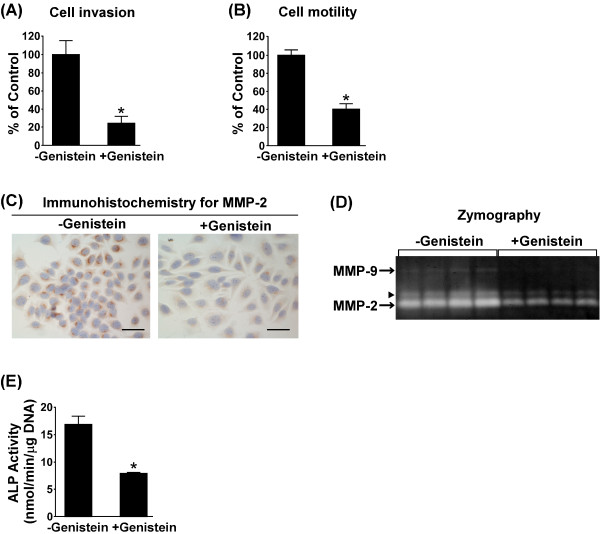
Effect of genistein on invasion, motility, MMP-2, andALP. (A and B) LM8 cells were treated for 3 days without or with 50 μM genistein and harvested by trypsinization. Cell invasion and motility assays were performed using either matrigel-coated membranes (A) or uncoated membranes (B). *p < 0.01 (compared with the values for untreated cells). (C) LM8 cells were treated for 3 days without (left panel) or with (right panel) 50 μM genistein, and immunohistochemical staining of MMP-2 was performed. Scale bar: 50 μm. (D) LM8 cells were treated for 3 days without or with 50 μM genistein. The activity of MMP-2 secreted into conditioned media during the last 24 h of the 3-day treatment was assayed by gelatin zymography. Arrowhead shows the preform of MMP-2. (E) LM8 cells were treated for 2 days without or with 50 μM genistein, and cellular ALP activity was measured. *p < 0.01 (compared with the values for untreated cells).